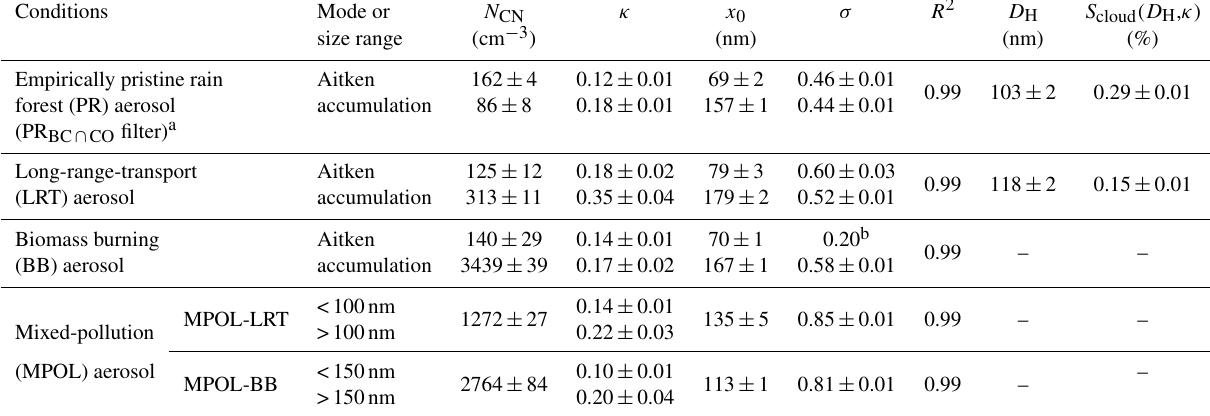
Table 2. Properties (position, x 0 ; integral number concentration, N CN ; width, σ ) of Aitken and accumulation modes from single or double lognormal fits of the total particle size distribution. Values are given as means of the case study periods, whereas corresponding seasonally averaged results can be found in the Part 1 study. The errors represent the uncertainty of the fit parameters. No meaningful double lognormal fit was obtained for the monomodal MPOL case – thus, a single lognormal fit was conducted to describe the properties of the main peak. For the cases PR BC ∩ CO and LRT with clearly resolved bimodal size distributions, values for the position of the Hoppel minimum, D H , as the intersection of fitted and normalized modes as well as estimated average peak supersaturation in cloud, S cloud (D H , κ ), according to Krüger et al. (2014) and Part 1 study are listed. The error in S cloud (D H , κ ) is the experimentally derived error in S . Analogous information for the PR BC , PR CO , and PR BC ∪ CO filters can be found in Table